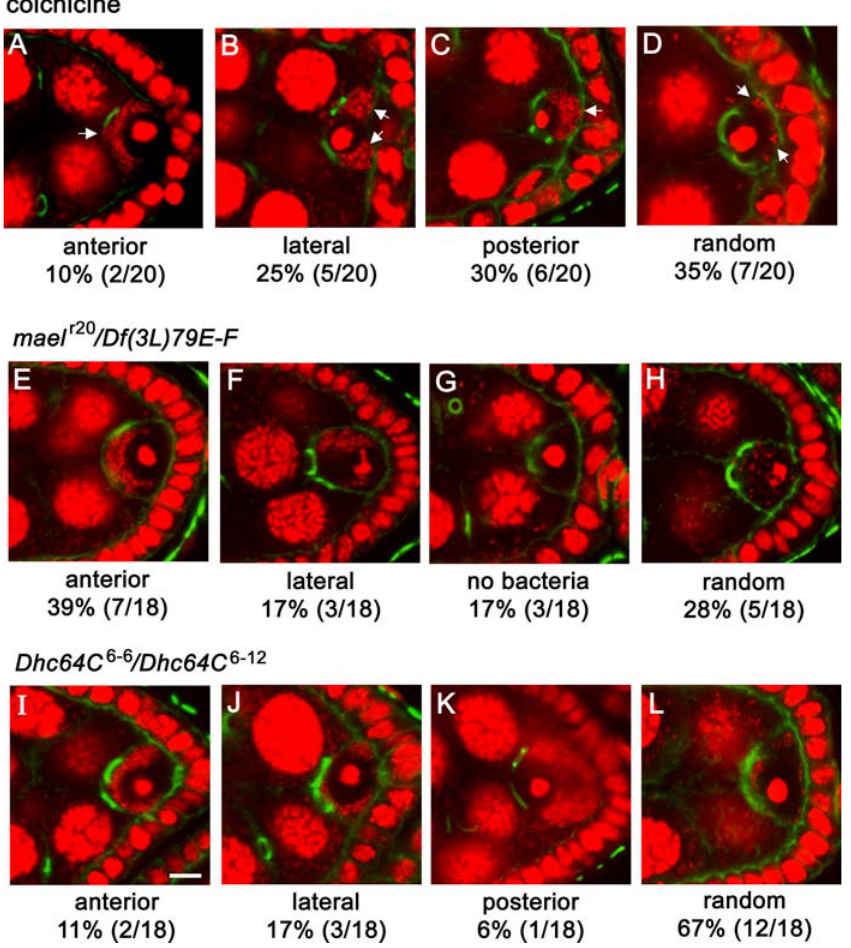
Figure 7. Perturbation of Microtubules and Cytoplasmic Dynein Disrupts Anterior Localization of Wolbachia in the Oocyte Wolbachia and host DNA are red (propidium iodide), and cell cortex and ring canals are green. (A–D) Stage 4–6 infected oocytes from colchicine-treated females. White arrows indicate Wolbachia . (E–H) Stage 4–6 infected oocytes from maelstrom r20 / Df (3L) 79E-F females. (I–L) Stage 4–6 infected oocytes from Dhc64C 6–6 / Dhc64C 6–12 females. DOI: 10.1371/